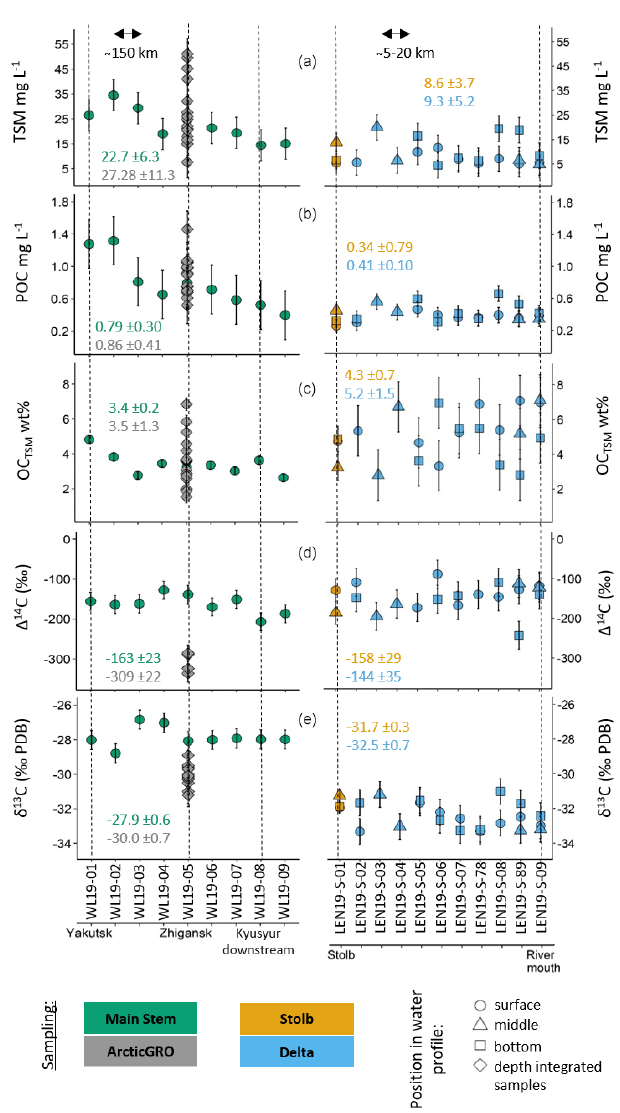
Figure 2. Distribution of studied parameters along the transect in the Lena main stem and the Lena delta and for the Arc- ticGRO dataset (mean ± SD); discrete values displayed on each panel represent the average ( ± SD) for every sampling group: (a) TSMmgL − 1 ; (b) POC, mgL − 1 ; (c) OC TSM , wt%; (d) (cid:49) 14 C of POC, ‰; (e) δ 13 C of POC, ‰.